Question: Sum up the contents of this chart in one sentence.
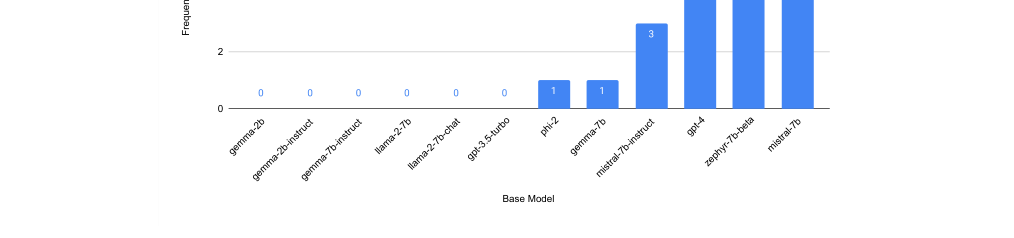
Answer: Frequency of base models (with fine-tuning) as the top performer for a task. Ties, namely for the customer_support task where most models attain 100% perfect scores, are excluded.